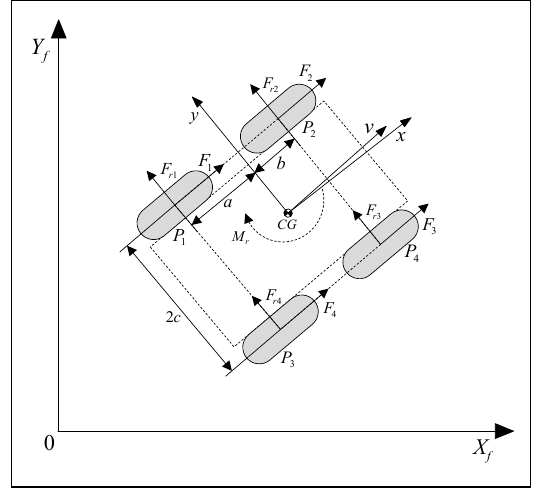
Figure 3. The active and reactive forces.